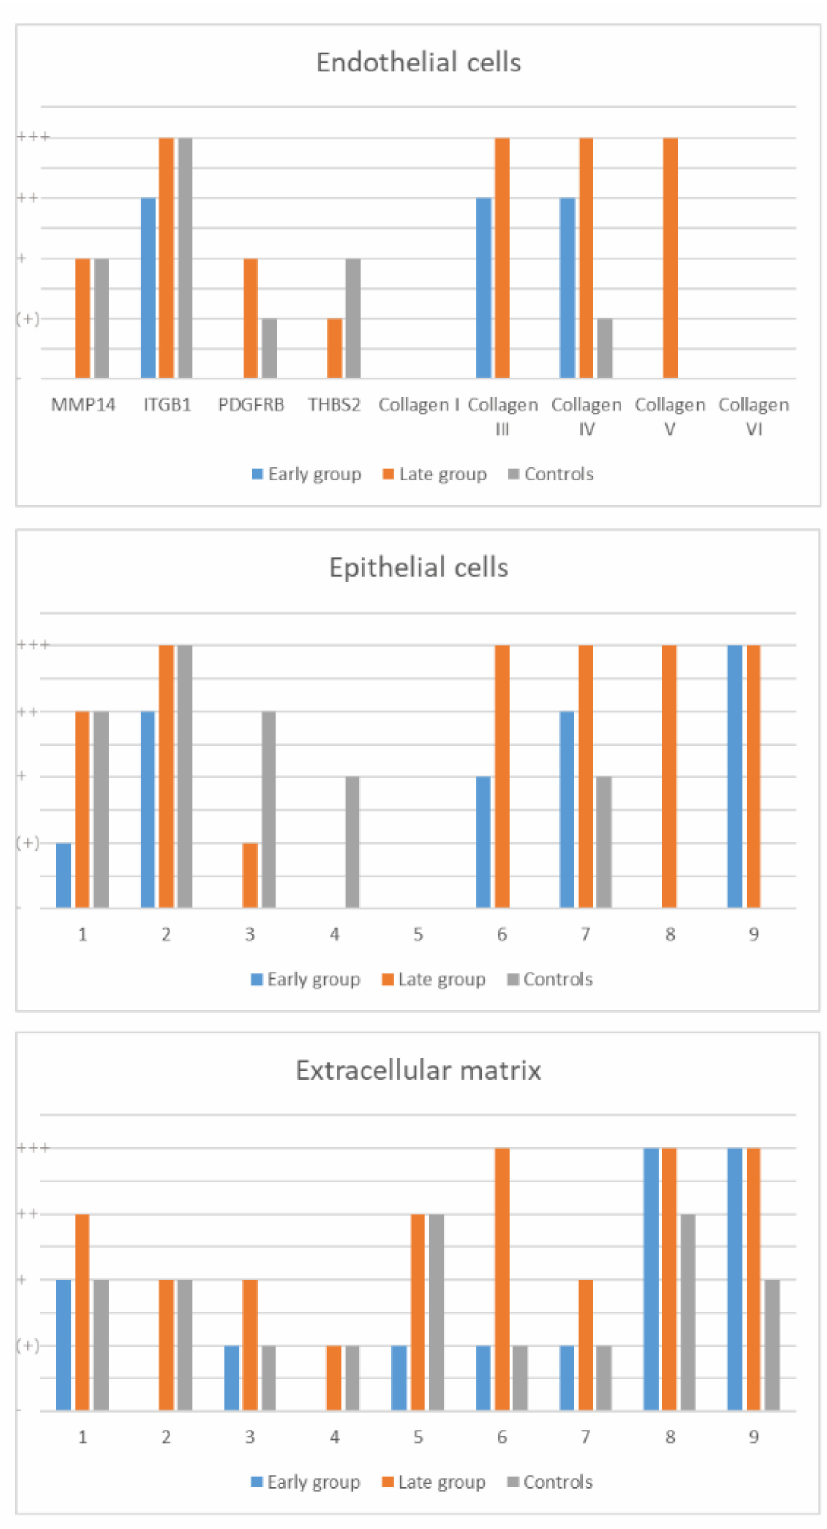
Figure 5. Semiquantitative analysis of the immunostaining. MMP14, matrix metalloproteinase 14; ITGB1, integrin beta type 1; PDGFRB, platelet derived growth factor receptor beta; THBS2, thrombospondin 2; +++, highly positive; ++, intermediate positive; +, slightly positive; (+), partially positive; -,